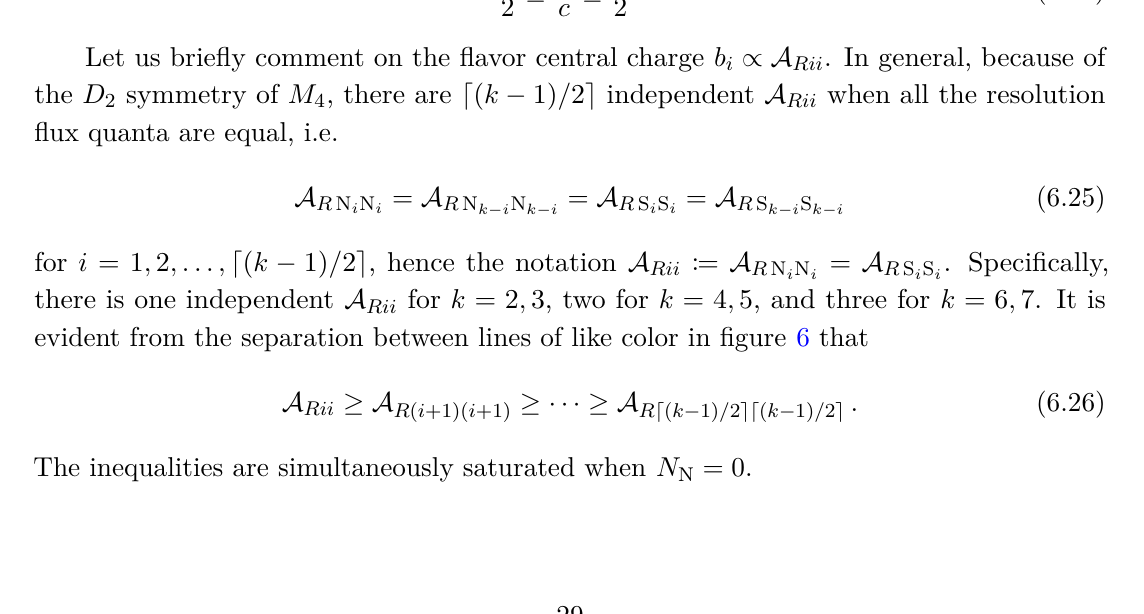
Figure 6. Plots of a , a/c , A Rϕϕ , A Rii for k = 2 to k = 7 with identical flux quanta N N for all i = 1 , . . . , k − 1 . N is treated as a continuous real parameter for visualization purposes. All N of the plots are evaluated with χ = − 2 and N = 10 . For a given k , there are d ( k − 1) / 2 e independent A Rii anomaly coefficients, which are proportional to the flavor central charges b i associated with the resolution cycles of M . We use solid lines for i = 1 , dashed lines for i = 2 , and dotted lines for 4 i = 3 where